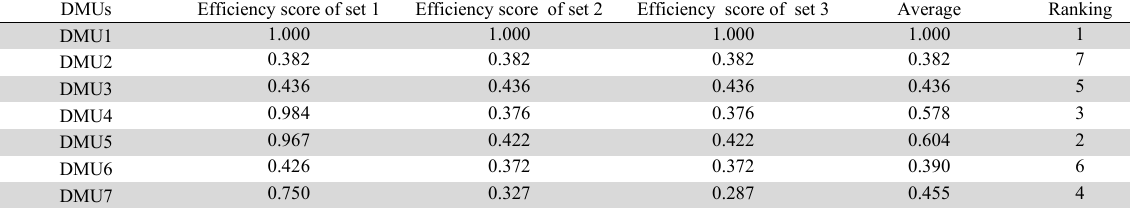
The efficiency scores of each DMU using DEA technique DMUs